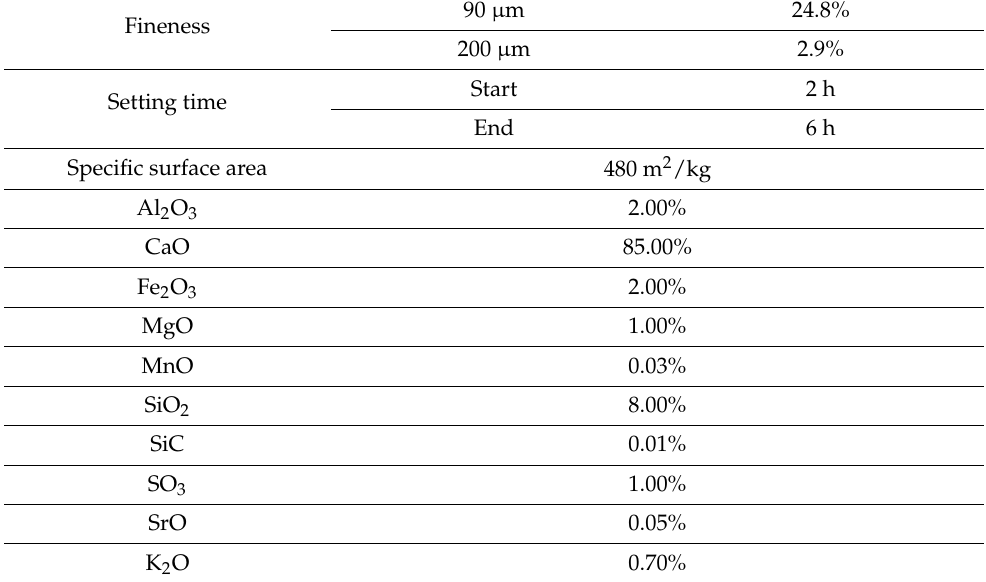
Table 1. Natural hydraulic lime characteristics (data provided by the manufacturer).